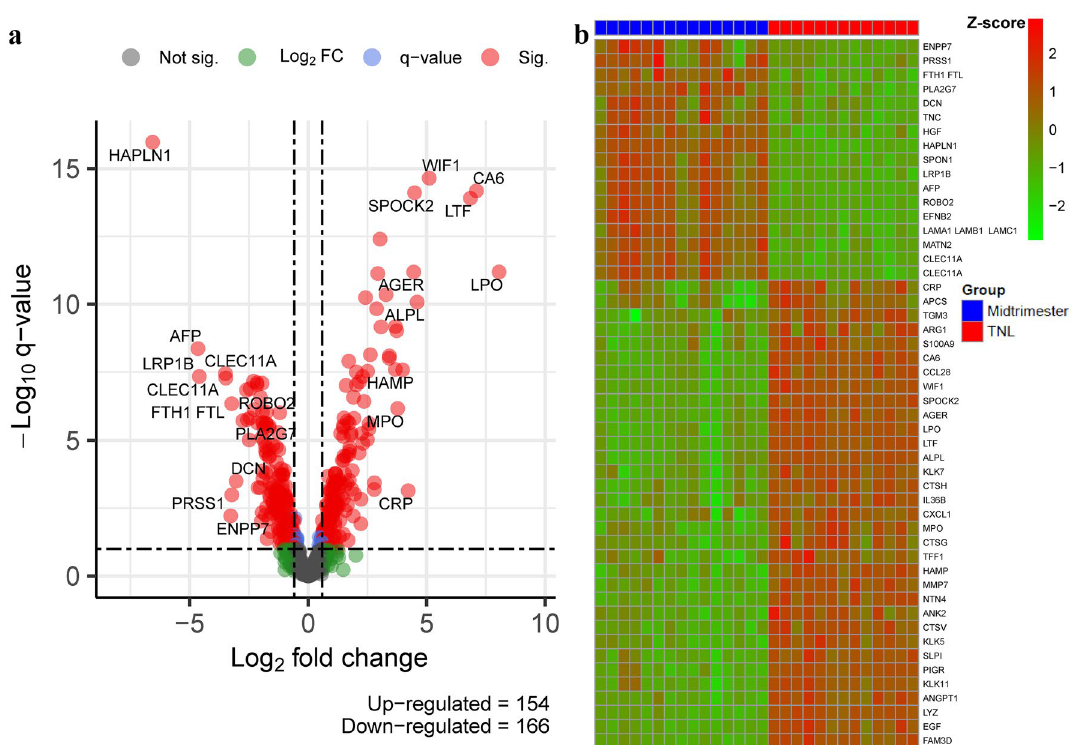
Figure 2. Differential protein abundance. The figure shows ( a ) the volcano plot of log 10 transformed adjusted p -values against log 2 transformed fold changes of 1310 amniotic fluid proteins and ( b ) the heatmap based on the 50 most-increased (in abundance) and the 50 most-decreased (in abundance) proteins between term and midtrimester samples. The R/Bioconductor packages, EnhancedVolcano , and pheatmap , were used to generate the volcano plot and heatmap, respectively 115–117